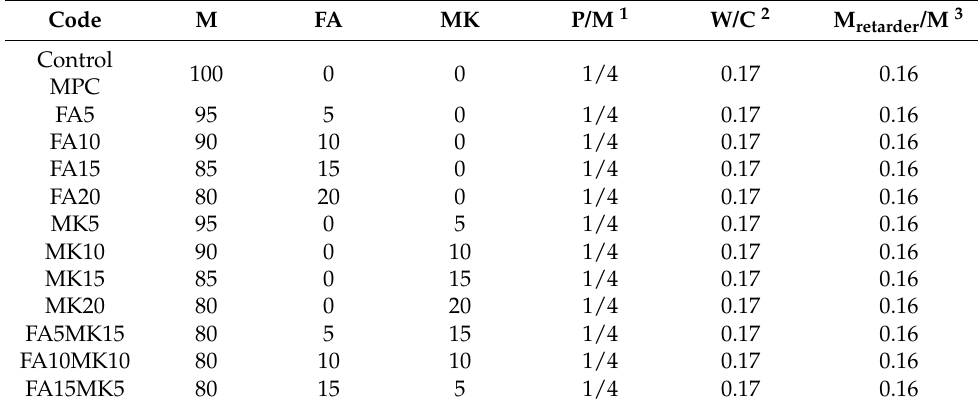
Table 2. Mix proportions of MPC mortars containing FA and MK (by wt/%).